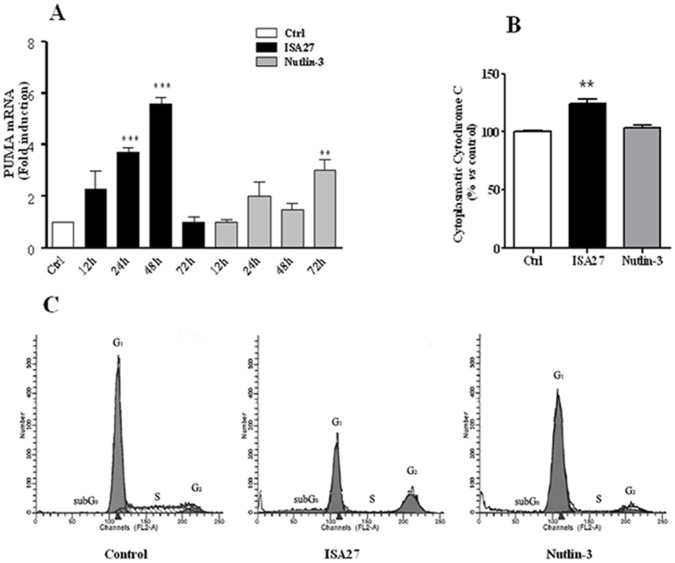
ISA27 induces an increase in PUMA mRNA levels, mitochondrial cytochrome c release, and DNA fragmentation.
11A) Relative quantification of PUMA mRNA: ISA27 induced a statistically significant increase in PUMA mRNA levels at 24 and 48 h. Nutlin-3 treatment resulted in a statistically significant increase at 72 h. 11B) Evaluation of cytosolic cytochrome c content: ISA27-treated cells showed a 25% increase in cytochrome c levels in the cytosolic fraction. Nutlin-3-treated cells did not give statistically significant results. 11C) Evaluation of DNA content: Frequency histograms from a representative experiment are shown. ISA27-treated cells showed a significant increase in the percentage of nuclei with hypodiploid DNA content at 72 h compared with control cells. In contrast, Nutlin-3 did not induce significant nuclear DNA fragmentation.